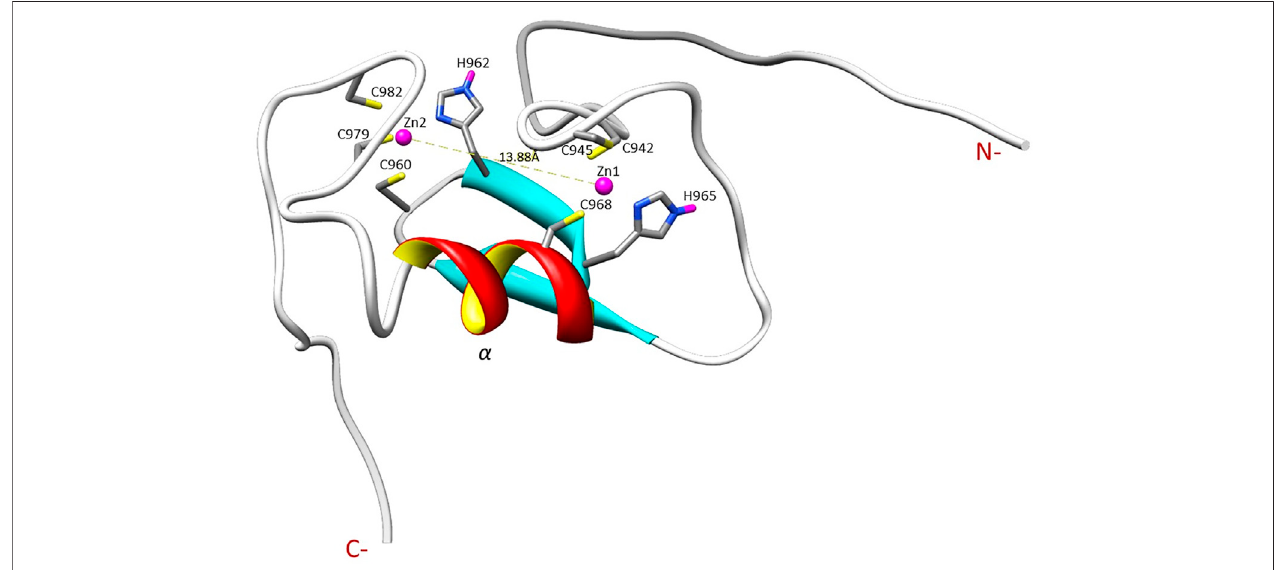
FIGURE 4 | Illustration of the zinc ions binding sites and the Zn ions distance in the R957C RING domain as appeared in the fi rst model of the family.